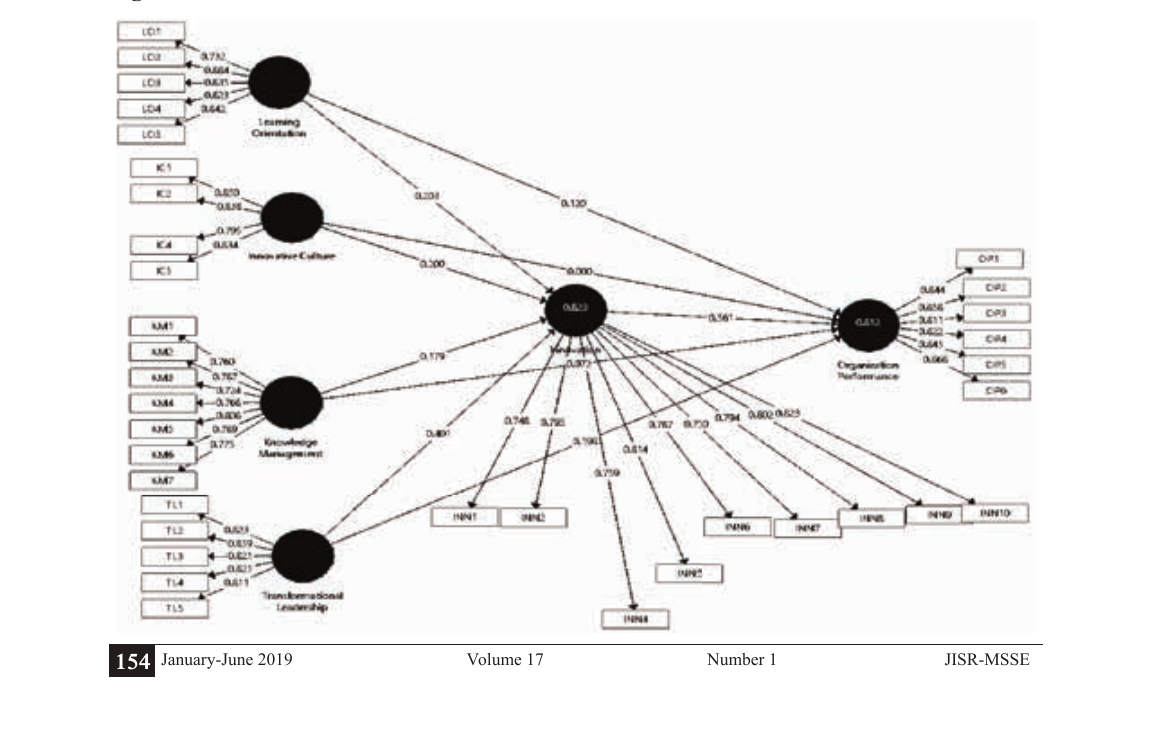
Figure 1. Measurement Model